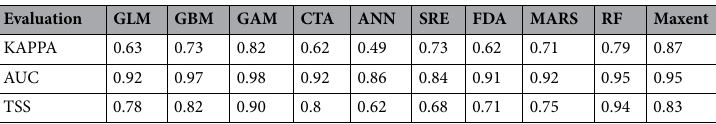
Table 1. performance of a single model used KAPPA, TSS, and ROC.